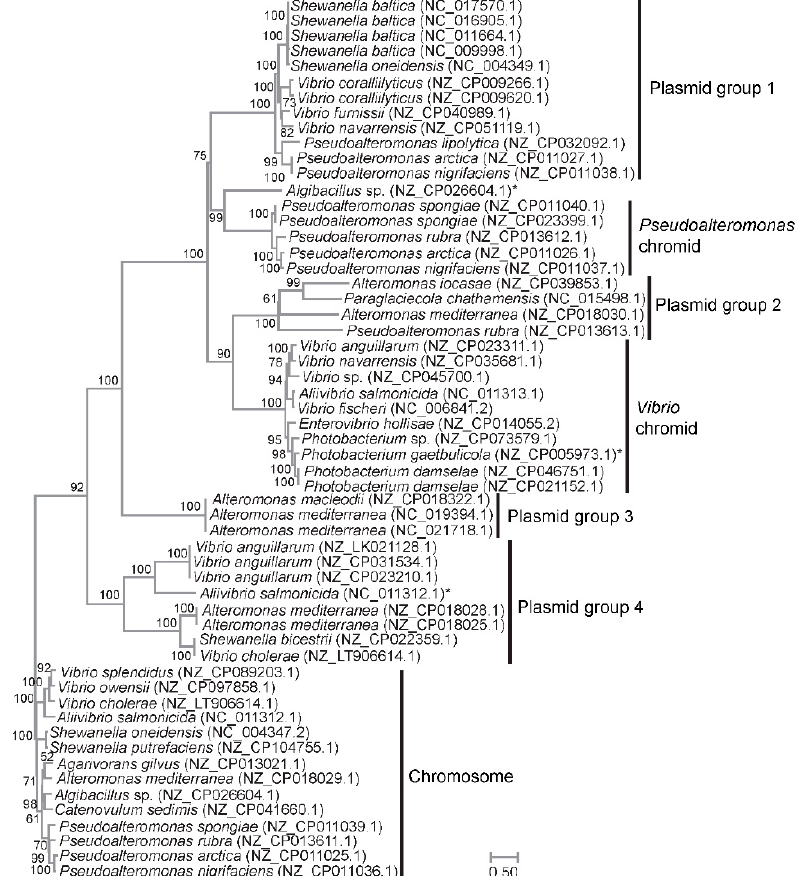
Figure 2. ML-tree based on the concatenated protein sequences of ParA and ParB and the WAG + G+I model. The tree shows the evolutionary relationships between chromidal sequences from Vibrio and Pseudoalteromonas , and sequences from plasmids carrying related ParA and ParB pairs. Chromosomal sequences were used as the outgroup. Clades containing plasmid sequences were designated Plasmid group 1–4 for clarity. Asterix denotes chromosomal sequences with an auxiliary pair of ParA and ParB. Bootstrap values (ML method, WAG + G+I model, 1000 pseudoreplicates) are associated with the nodes. Branch lengths are proportional to the number of substitutions per site (see scale).